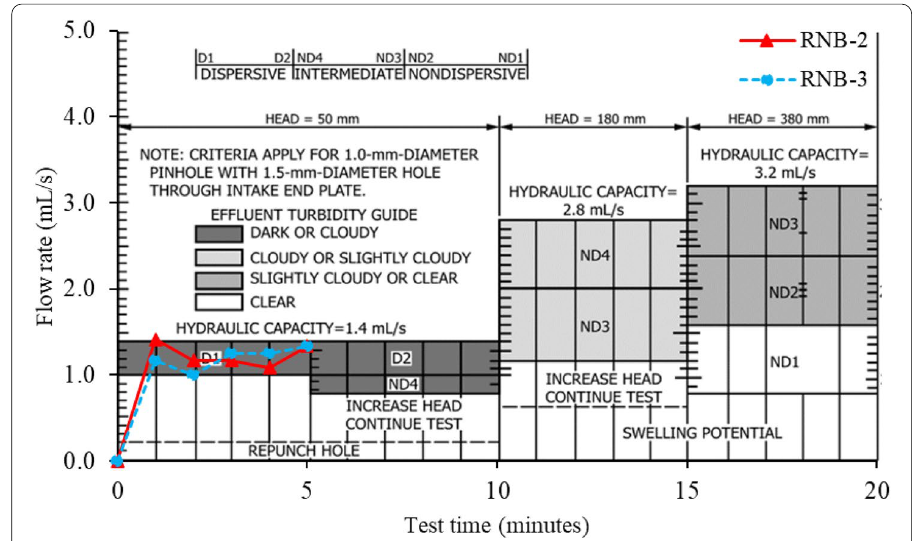
Fig. 11 Flow rate and dispersive grade of SP‑SM soils